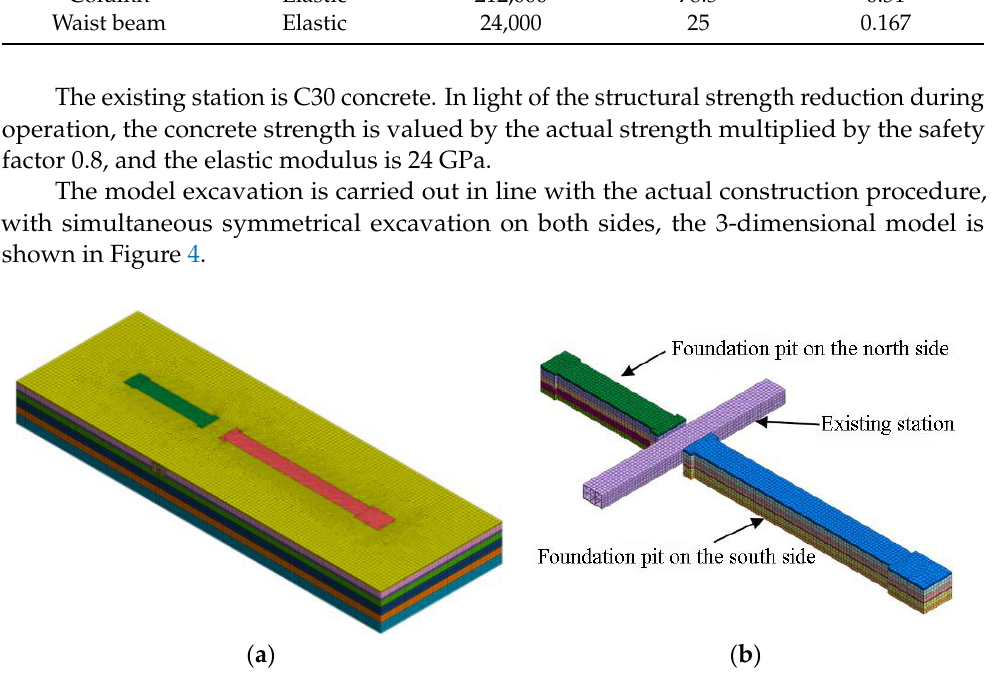
Table 6. Calculating model main geotechnical parameters table.